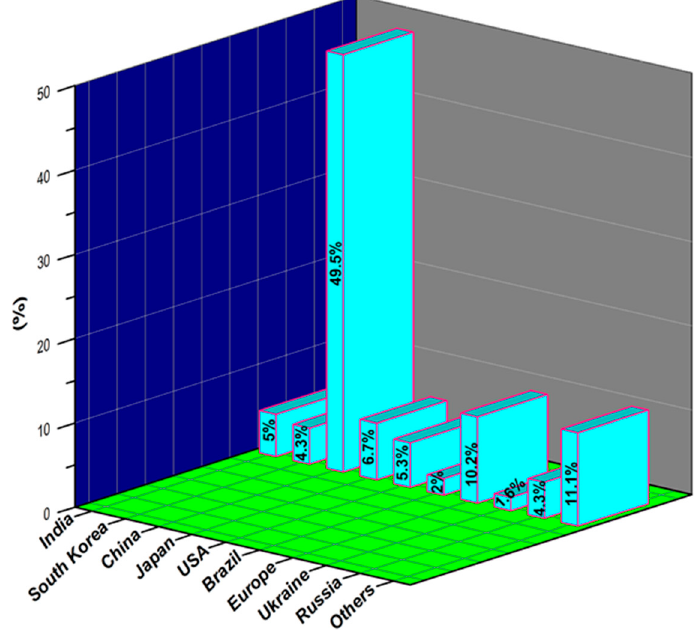
Table 2. Chemical composition of GGBS.